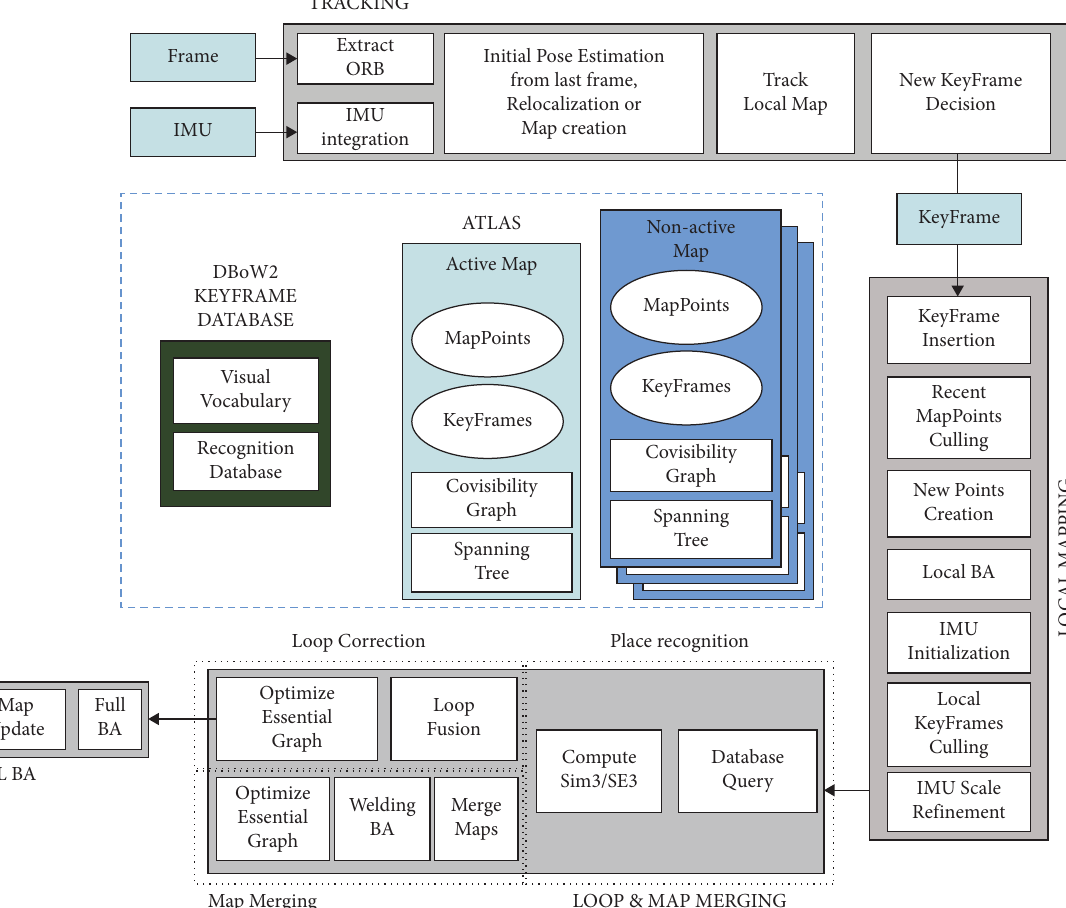
Figure 11: ORB-SLAM3 frame diagram, excerpt from paper